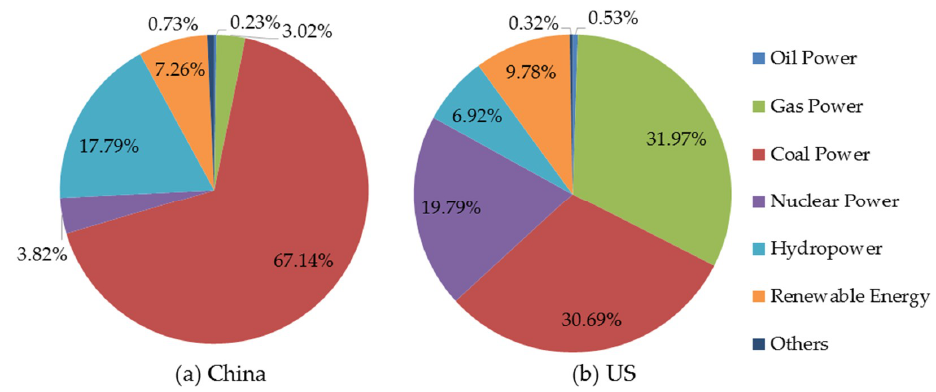
Figure 2. A comparison of the power supply structures of China and the United States in 2017. Source: BP Amoco [2].